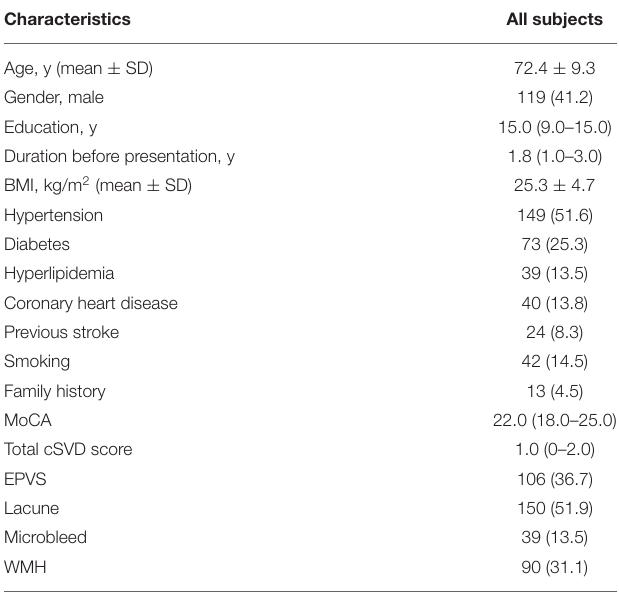
TABLE 1 | Baseline characteristics of the subjects with amnestic disorders ( n = 289)*. Characteristics